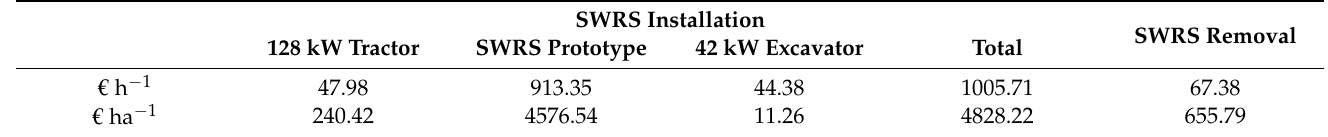
Table 2. Final cost for installation and removal of the SWRS performed two weeks